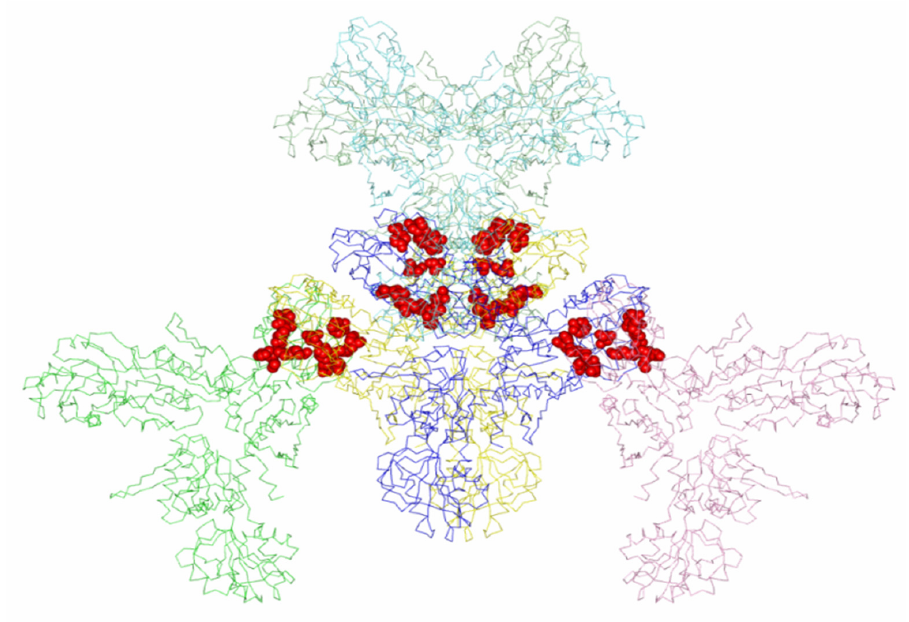
Figure 4. Hexameric enzyme molecule and subunits of other molecules in contact with it in the P4 1 2 1 2 crystal modification. Amino acid residues involved in intermolecular contacts are shown.